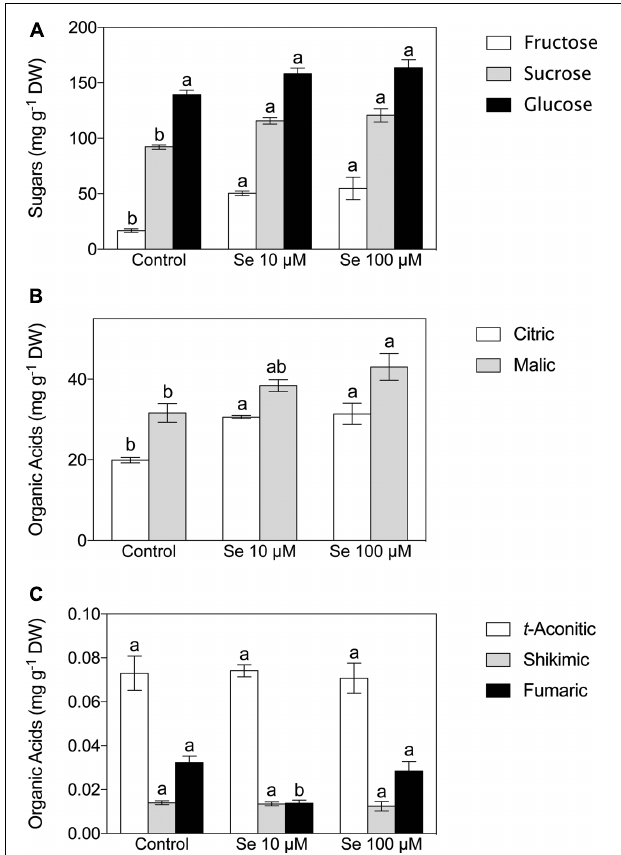
FIGURE 2 | Total phenols, total flavonoids and total flavonols concentration in strawberry fruits grown in a full nutrient (control) and a nutrient solution either supplied with 10 or 100 µ M Se. Data are reported in the graph as means ± SE, n = 3. The statistical significance was tested by means of ANOVA with Tukey post-test. Different letters indicate statistically different values ( P ≤